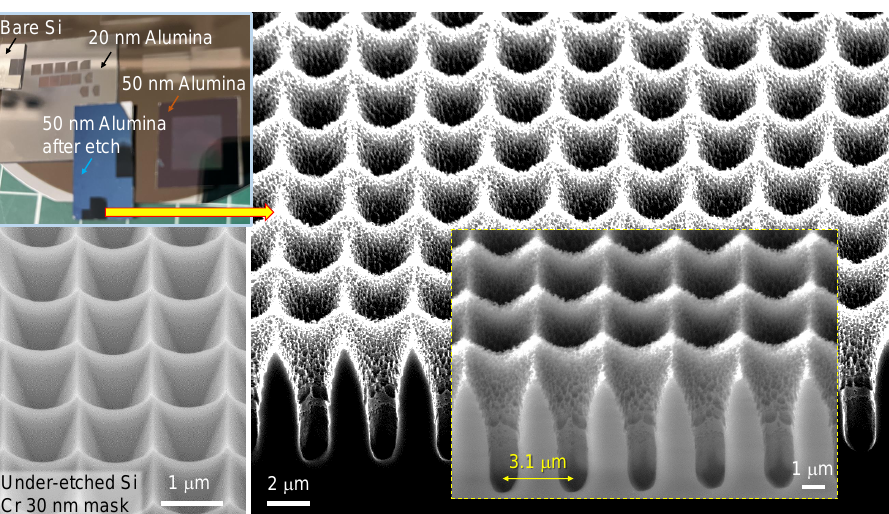
Figure 5. The colour photo shows Si samples with different Al 2 O 3 masks before and after dry plasma etching. Left: the SEM image shows the Si PhC made by plasma etching developed for an under- etched zero-ridge tee-pee PhC pattern using a 30 nm-thick Cr mask [8]. Similar plasma etching conditions as used in the case of 30 nm of Cr showed very different tee-pee patterns for the 50 nm alumina mask ablated by E p ≈ 4.2 nJ pulses (at focus). Etched by SF 6 :CHF 3 :O 2 at a 5:1:1 flow rate ratio for 15 min at ICP 180 W and 0 W bias (Cr mask) [8] and 30 min at ICP 140 W and 5 W bias (Al 2 O 3 mask); He pressure of 2.70 kPa at a process pressure of 2.5